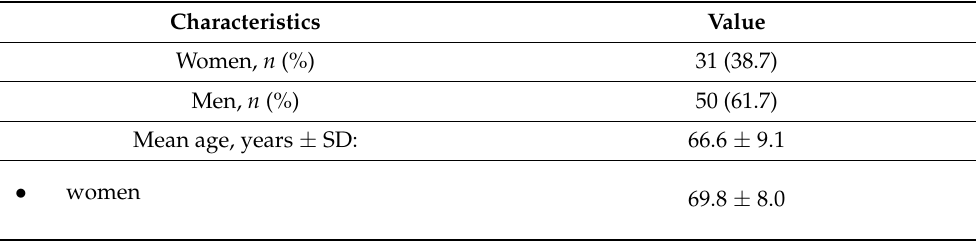
Table 1. Characteristics of study